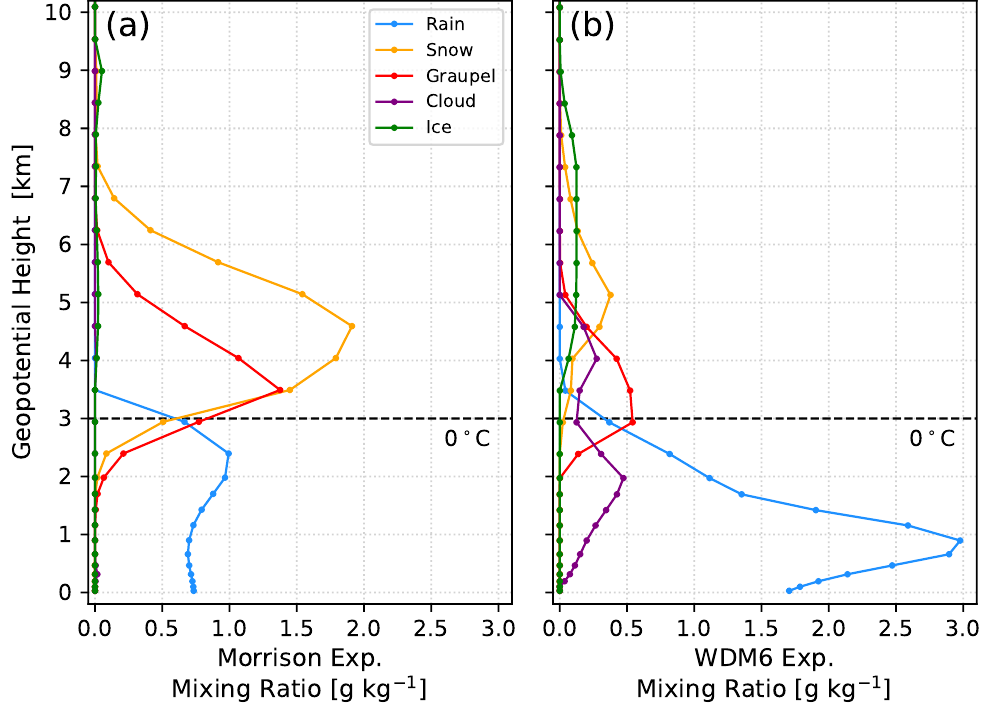
Figure 9. Vertical profile of mixing ratio (g kg − 1 ) for each hydrometeor type extracted from the numerical model at the point 37.71 ◦ N, − 124.10 ◦ E from the ( a ) Morrison and ( b ) WDM6 experiments. This location is at the reflectivity maximum along the lowest ray in g03r (see Figure 5). The dots along the curves indicate the vertical spacing between model levels in the numerical model. The black dashed line indicates the freezing level in the corresponding